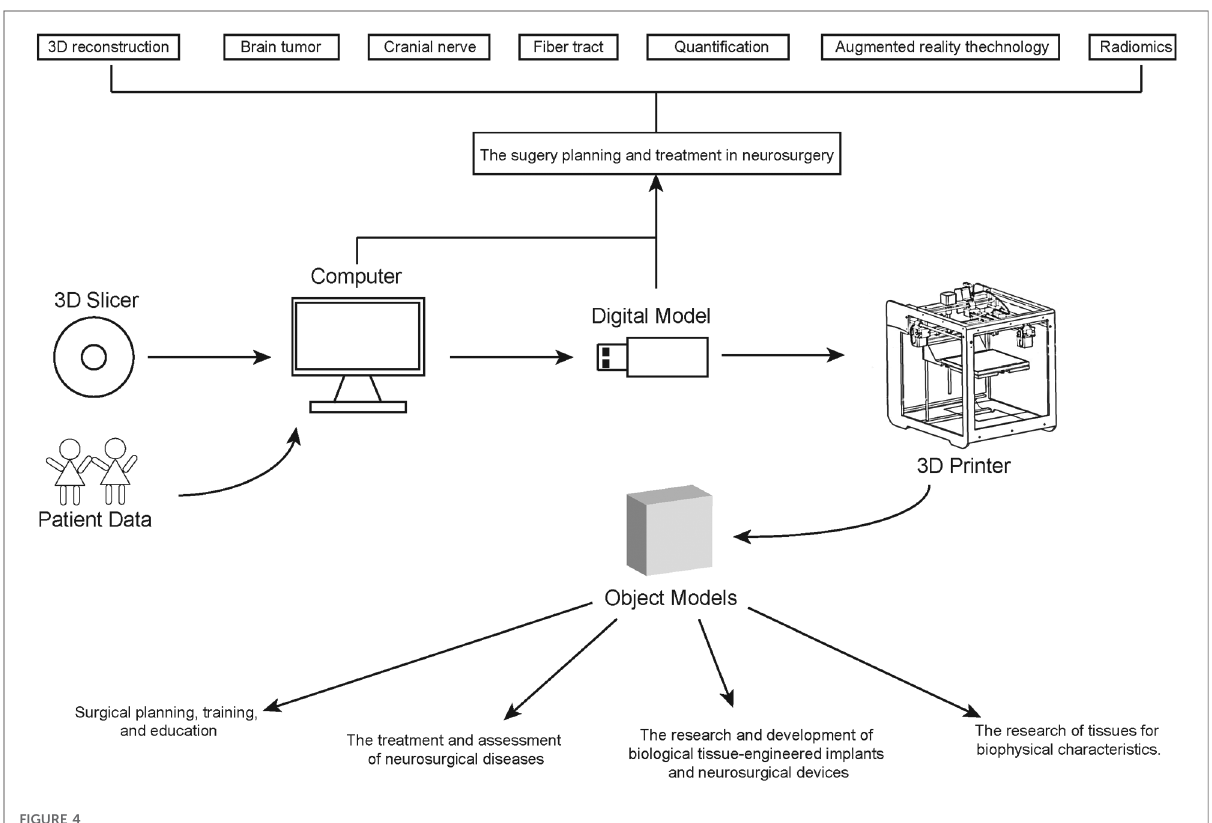
FIGURE 4 3D printing and 3D slicer in understanding and treating neurosurgical